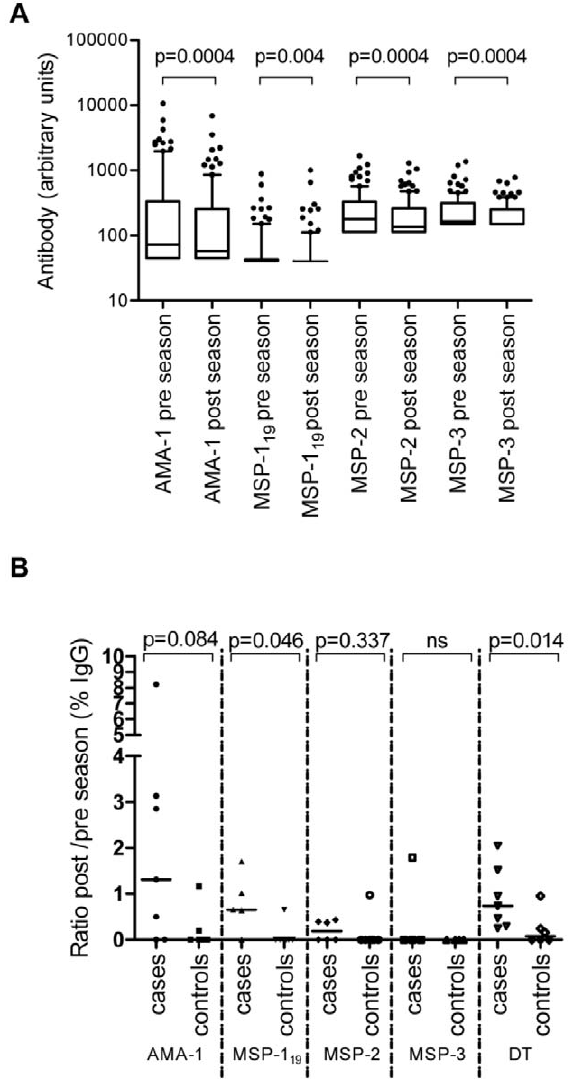
Figure 8. Boosting of circulating MBC numbers by recent malaria infection. (A) Pre- and post-malaria season plasma Ab concentrations to the different malaria Ags are shown for all participants for whom paired samples were available (n=99), pooled across all age groups. Values below the antigen-specific cut-off (as described in the methods) were given the cut-off value. Box plots indicate the 25 th , 50 st and 75 th percentile, with whiskers representing the 10th and 90th percentiles. Outliers are indicated by spots. (B) Comparisons of the ratio of post-season MBC to pre-season MBC for cases (individuals having a . 1.5 fold increased Ab concentration post season for at least one of the malarial Ags) and controls. P values are given for the Mann-Whitney test, adjusted for multiple comparisons using the Bonferroni method.